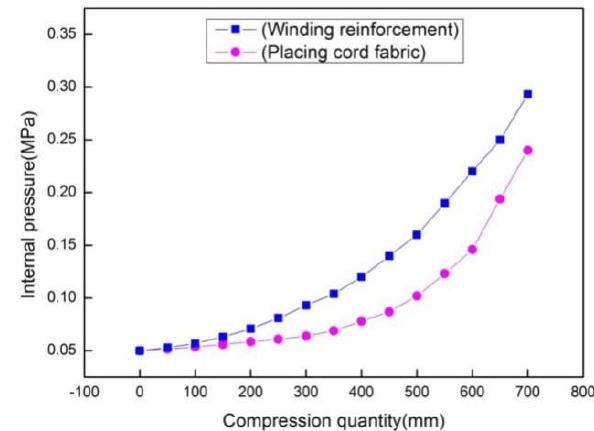
Figure 16: The relationship between compression and internal pressure